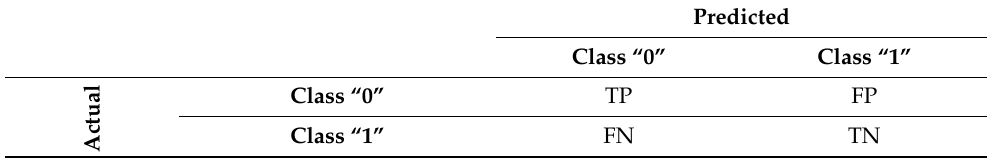
Table 1. Confusion matrix explanation for a binary classification problem.